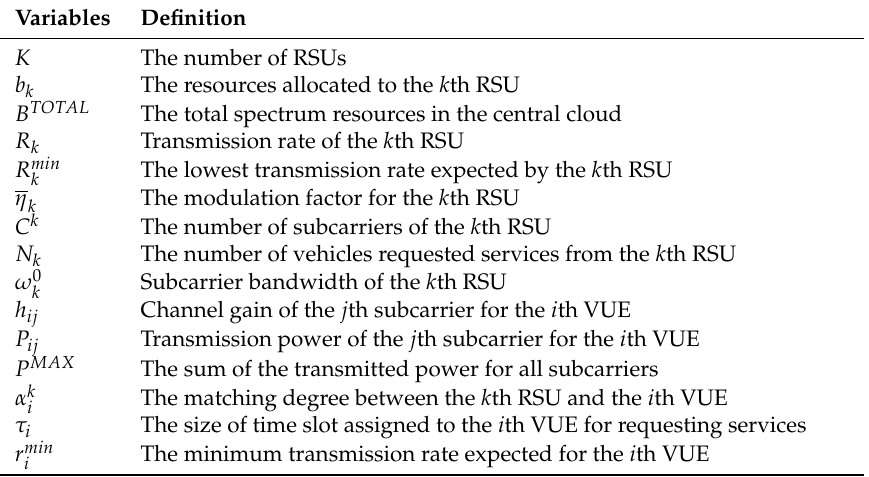
Table 1. The description of variables in hierarchical resource allocation